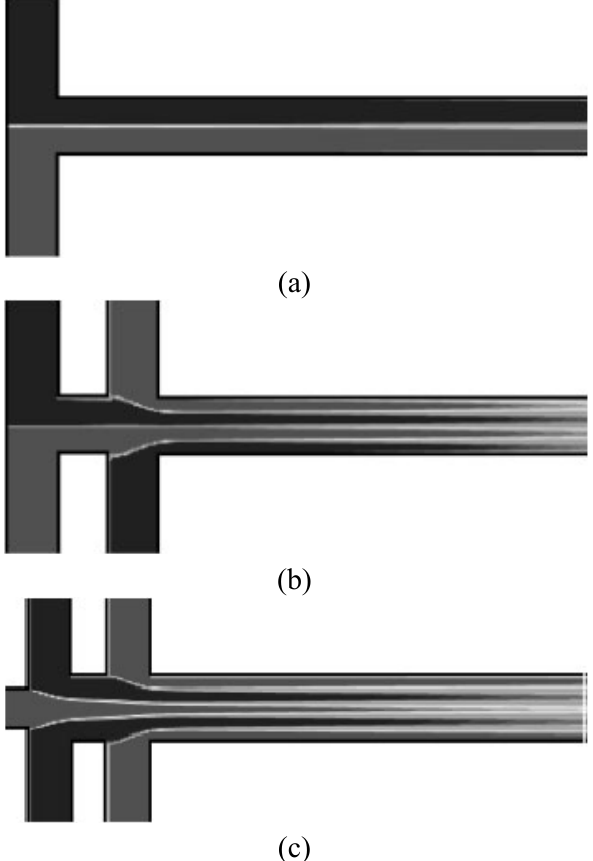
Figure10. Three types of inlet channels; (a) single “T”, (b) double “T” and (c) double cross channel (from Fu and Tsai [21]).